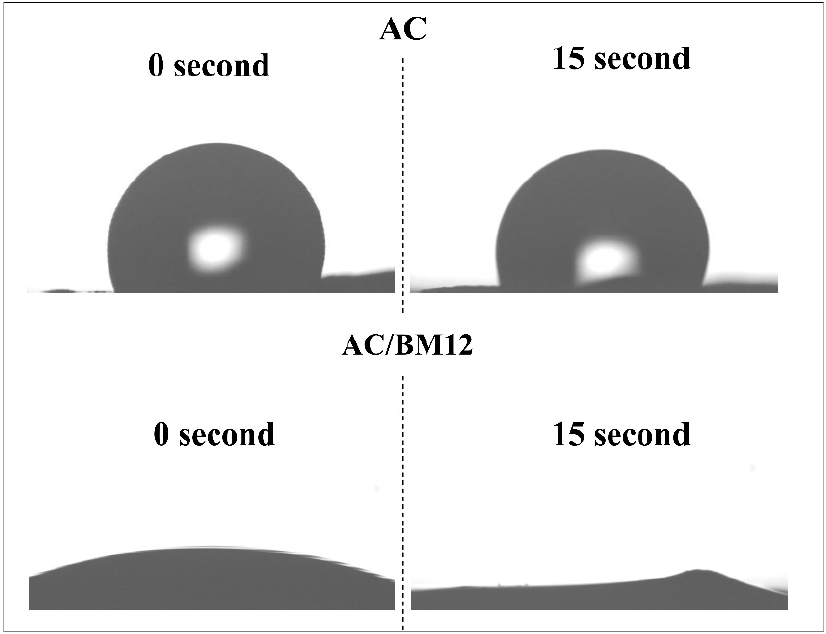
Figure 7. Dynamic water contact angle measurement for AC and AC/BM12 samples at 0 s and 15 s after dropping water.